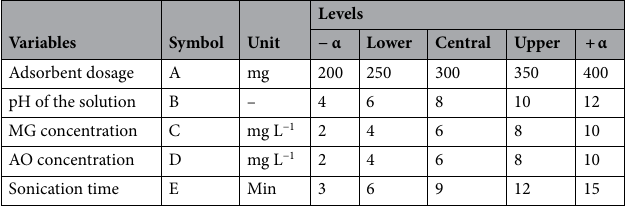
Table 3. Levels of the variable in the